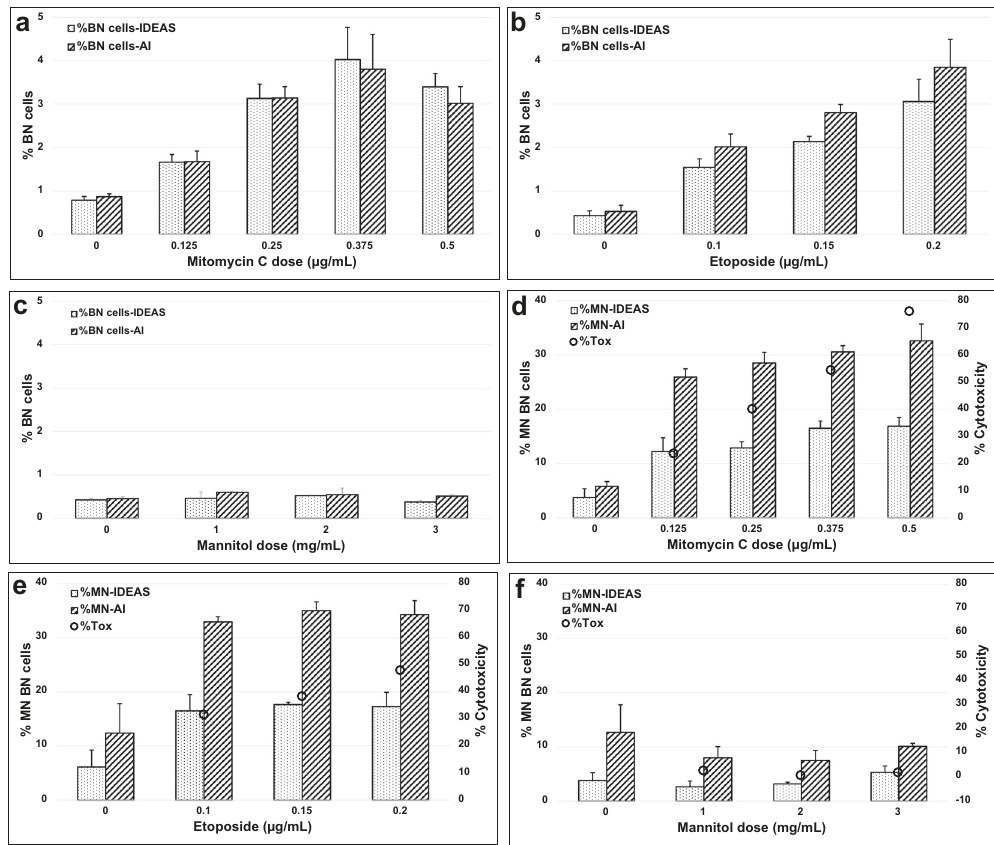
Fig. 6 Frequency of BN cells and MNed BN cells in the non-Cyt-B version of the MN assay. The percentage of BN cells quanti fi ed by IDEAS (dotted bars) and Amnis AI (striped bars) for ( a ) Mitomycin C (MMC), ( b ) Etoposide and ( c ) Mannitol. The percentage of MNed BN cells by IDEAS (dotted bars) and Amnis AI (striped bars) are shown for ( d ) MMC, ( e ) Etoposide and ( f ) Mannitol and following a 3 hr exposure and 24 h recovery. Cytotoxicity quanti fi ed by cell counts is also indicated (black